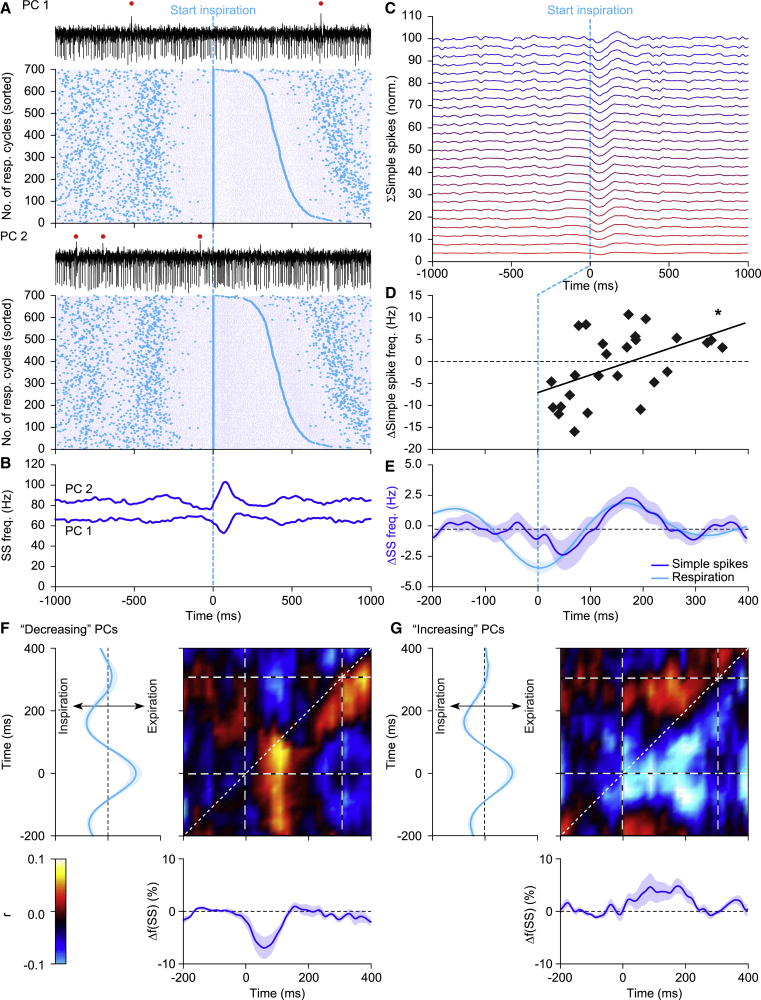
Eupneic Respiration Is Associated with Both Increased and Decreased Simple Spike Firing(A) During the respiratory cycle, simple spike (SS) modulation can either be predominantly decreasing or increasing, as illustrated by two representative PCs recorded simultaneously in the same animal. The raster plots are aligned on inspiration start and sorted according to the interval to the next inspiration. Large cyan dots indicate inspiration start and small blue dots the SSs. The red dots on top of the traces indicate complex spikes.(B) Convolved peri-stimulus time histograms of the two PCs shown in (A).(C) Stacked line plot of the instantaneous SS firing rates of all 26 PCs displaying a statistically significant SS modulation firing during unperturbed breathing. SS firing is displayed in percentage of baseline firing and normalized so that the upper line reflects the population average. The PCs are ordered from the strongest decrease (bottom, red line) to the strongest increase (top, blue line) in SS modulation. Each trace is aligned to inspiration start.(D) Scatterplot of moments of maximal modulation per PC, showing a correlation between the time of maximum modulation and its amplitude (r = 0.48, p = 0.012, Spearman rank correlation). Note that on average, as well as at individual cell level, the suppression of SSs preceded the increase.(E) Overall, the SSs were found to follow rather than to lead the respiration.(F) Correlation matrix showing a positive correlation between SS firing (blue trace [bottom] shows convolved peri-stimulus time histogram triggered on inspiration start) and respiration (cyan trace, left) based on trial-by-trial variance analysis in PCs that predominantly showed decreased SS firing rate linked to the respiratory cycle. Average of 13 PCs during unperturbed breathing. Note that the main simple spike activity follows the respiration (red area is below the 45° line).(G) Similar analysis of the 13 PCs that predominantly showed increased SS firing during the respiratory cycle, with mostly negative correlation. Thus, for both types of PCs, the correlation was opposite to their mode of modulation, indicating that the shallower the respiration, the stronger the SS modulation. Lines indicate averages and shaded areas SEM.See also Figure S2.